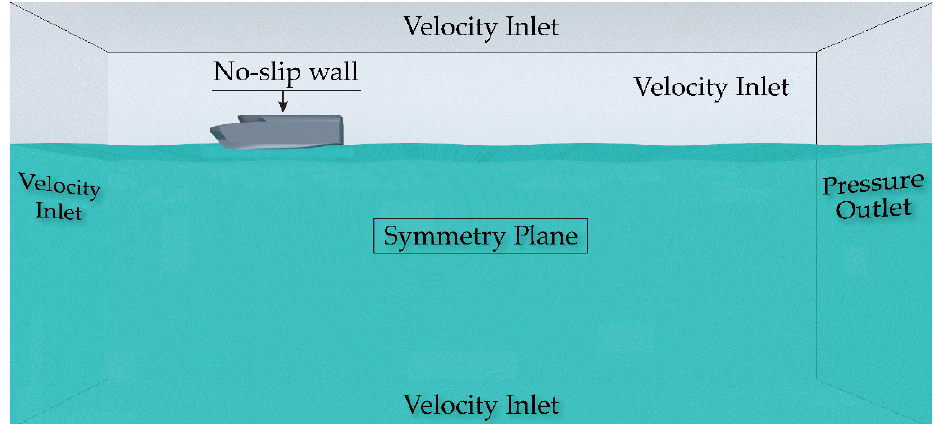
Figure 4. Boundary conditions of the computational domain.